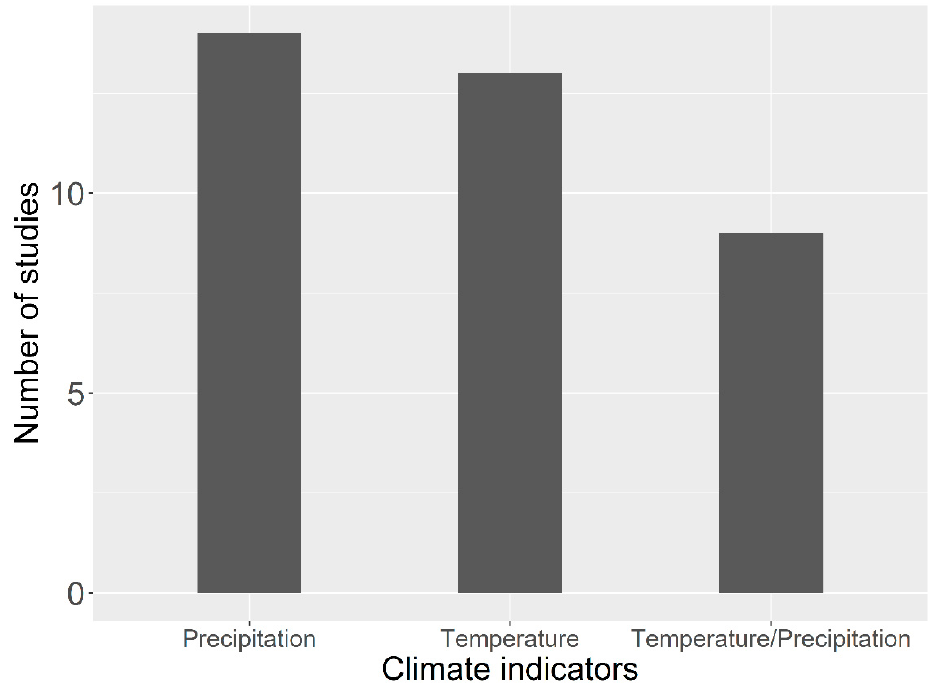
Figure 4. The number of studies indicating which climate indicators drive the ecosystem in the Tibetan Plateau. Both precipitation and temperature contribute equally to ecosystem functioning. The list of citations and their DOIs are provided in the Supplementary Materials.